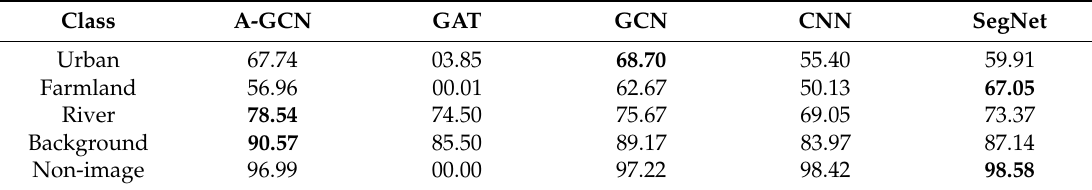
Table 6. Comparison of pixelwise F1-scores for individual classes with four state-of-the-art methods.